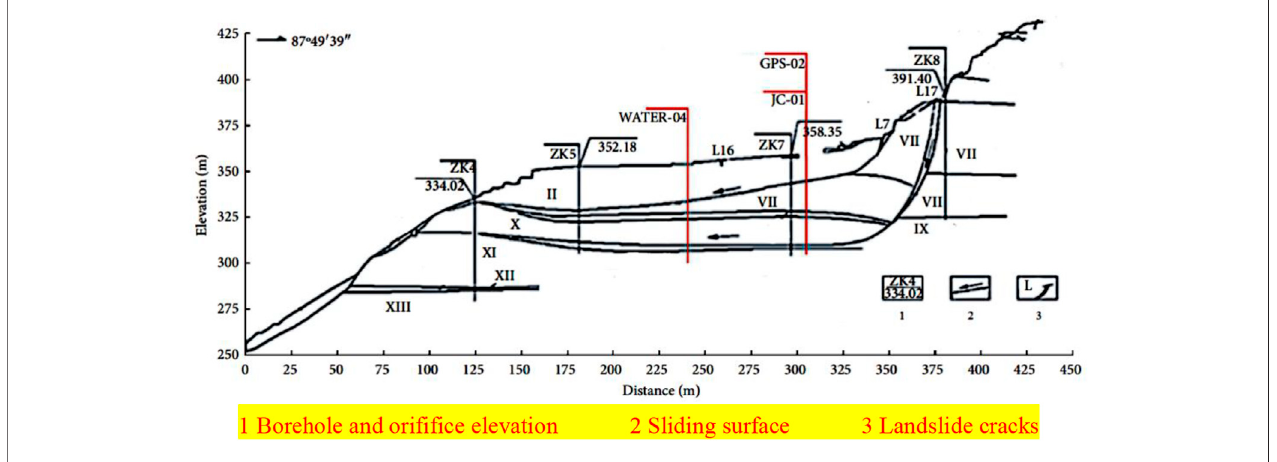
FIGURE 1 | Engineering geological map of typical